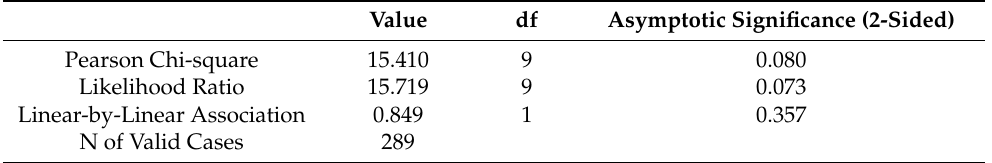
Table 14. Chi-square test on the correlation between the position/function of respondents and the assessment of the role of the professional accountant in a digital environment.